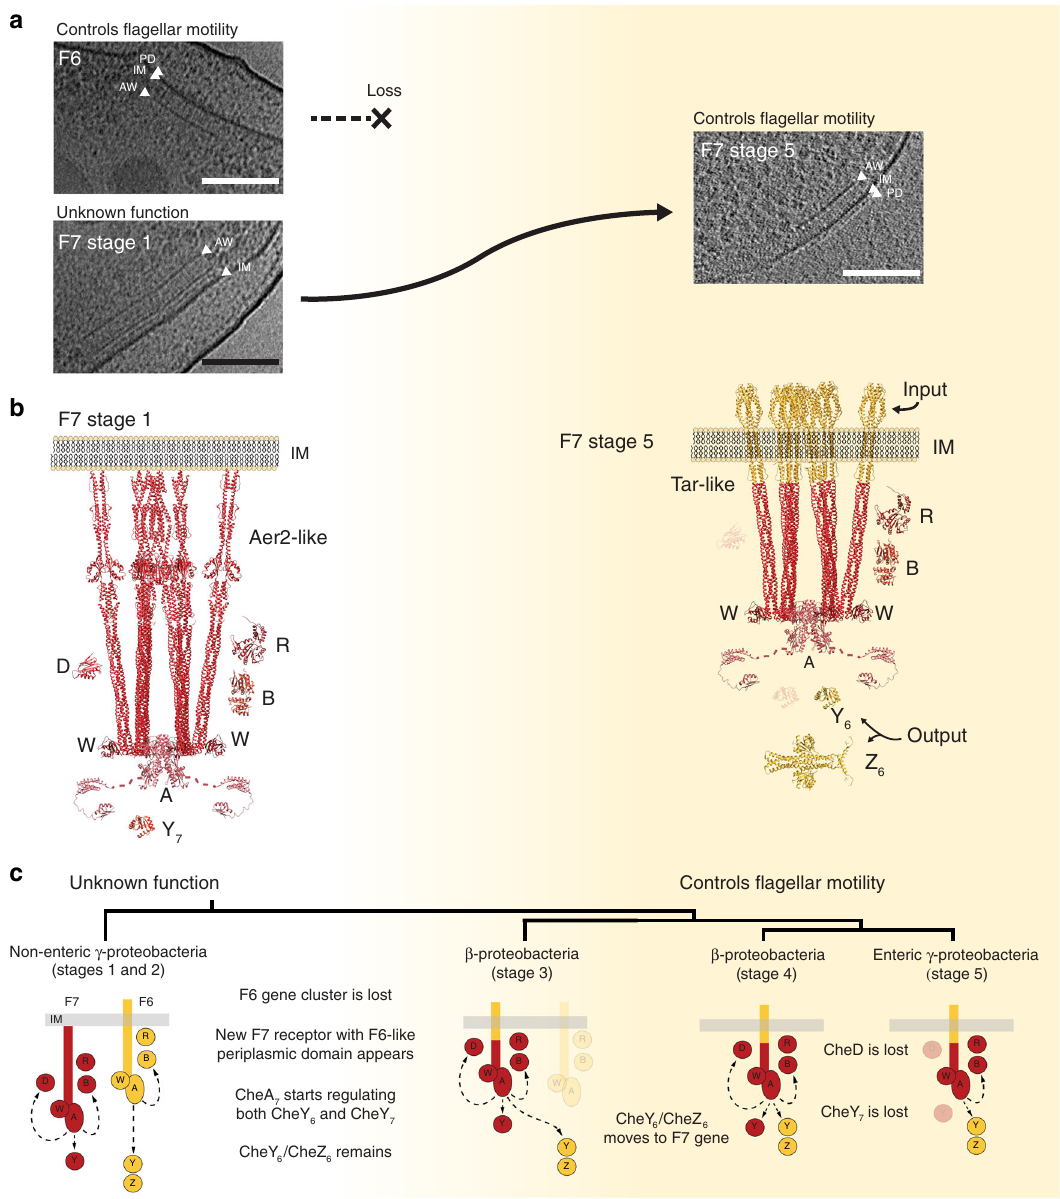
Fig. 6 Evolution of the F7 chemosensory array in non-enteric γ -proteobacteria. F7 chemosensory systems acquire F6-like ultrastructure and function. a Tomographic slices showing F6 and F7 stage 1 chemosensory arrays in the same P. aeruginosa cell (left) and an F7 stage 5 chemosensory array in E. coli (right). Over the course of evolution, the F6 system is lost and the F7 system evolves similar ultrastructure and function to the F6 system. Features to identify chemoreceptors are highlighted: periplasmic domain (PD), inner membrane (IM), and CheA/CheW layer (AW). b Molecular models of F7 chemosensory arrays in P. aeruginosa (left) and E. coli (right) built based on 64,65 . Proteins displayed in this representation are: CheA (A), CheB(B), CheR (R), CheD(D), F7-CheY (Y 7 ), F6-like CheY (Y 6 ), and F6-like CheZ (Z 6 ). Models are colored according to their hypothetical original class: F7 (red) and F6 (yellow). c Working model of the evolution of the F7 chemosensory system in γ -proteobacteria and β -proteobacteria. Scale bars are 50 of the IM, the CheA/CheW baseplate and intermediate layers. Measurement uncertainty was estimated (coverage factor k = 2) for determining the center of each peak in pixels 44 . The measurements in Supplementary Table 4 were made using one array, and they agree with the values obtained from measurements in the sub-tomogram averages described above. The general distances reported for the layers in Fig. 2 are averages of the measurements in each organism with propagated uncertainty.